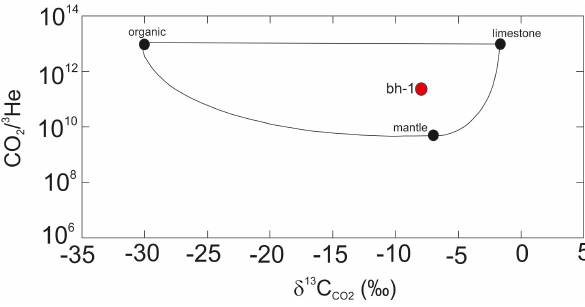
Figure 4. Genetic diagram CO 2 / 3 He versus δ 13 C CO ter Sano and Marty, 1995) for the borehole gas